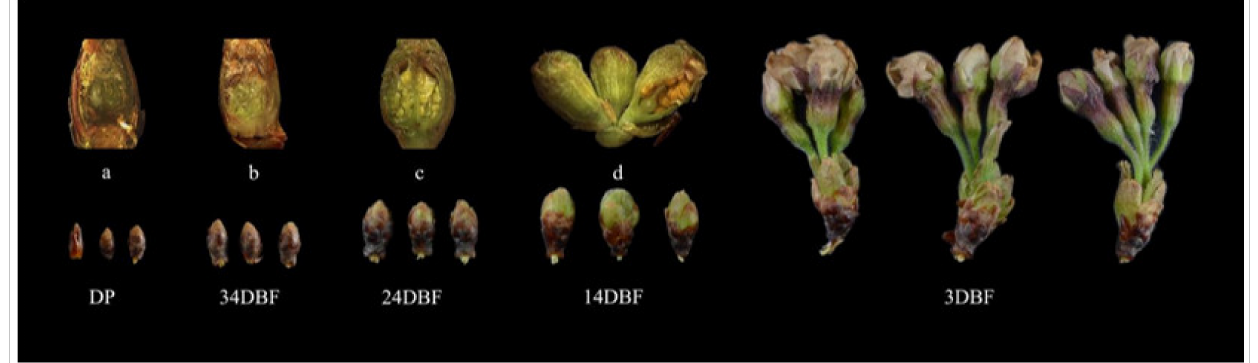
Figure 7. Flower buds of Prunus × yedoensis ‘Somei-yoshino’ for qRT-PCR. DP:dormant period, 34DBF:34 day before flowering, 24DBF:24 day before flowering, 14DBF:14 day before flower- ing,3DBF:3 day before flowering. ( a – d ) are the internal morphology of flower bud samples DP, 34DBF, 24DBF, 14DBF, 3DBF respectively.